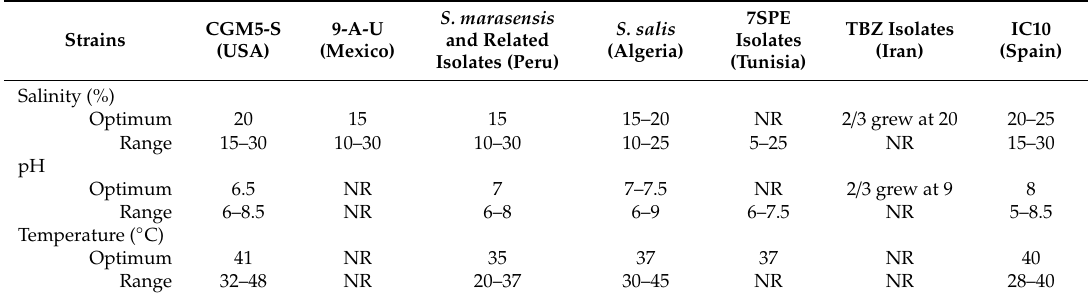
Figure 5. Physicochemical tolerance experiments for Salicola str. CGM5-S host and CG φ 29 phage. Panels A, B, and C show maximal growth rates (µMax) during 48 h salinity, pH, and temperature exposure experiments for the CGM5-S host. Panels D, E, and F show CG φ 29 phage titer following exposure to salinity treatments for one year, and pH and temperature treatments over a 72 h time-course, respectively. Bar graphs represent non time-course experiments; line graphs represent time-course experiments. Values are means ± Standard Deviation (n = 3). Different letters on bars denote statistically significant differences (p < 0.05) among treatments. Table 1. Comparison of physicochemical responses of CGM5-S and other described Salicola 1